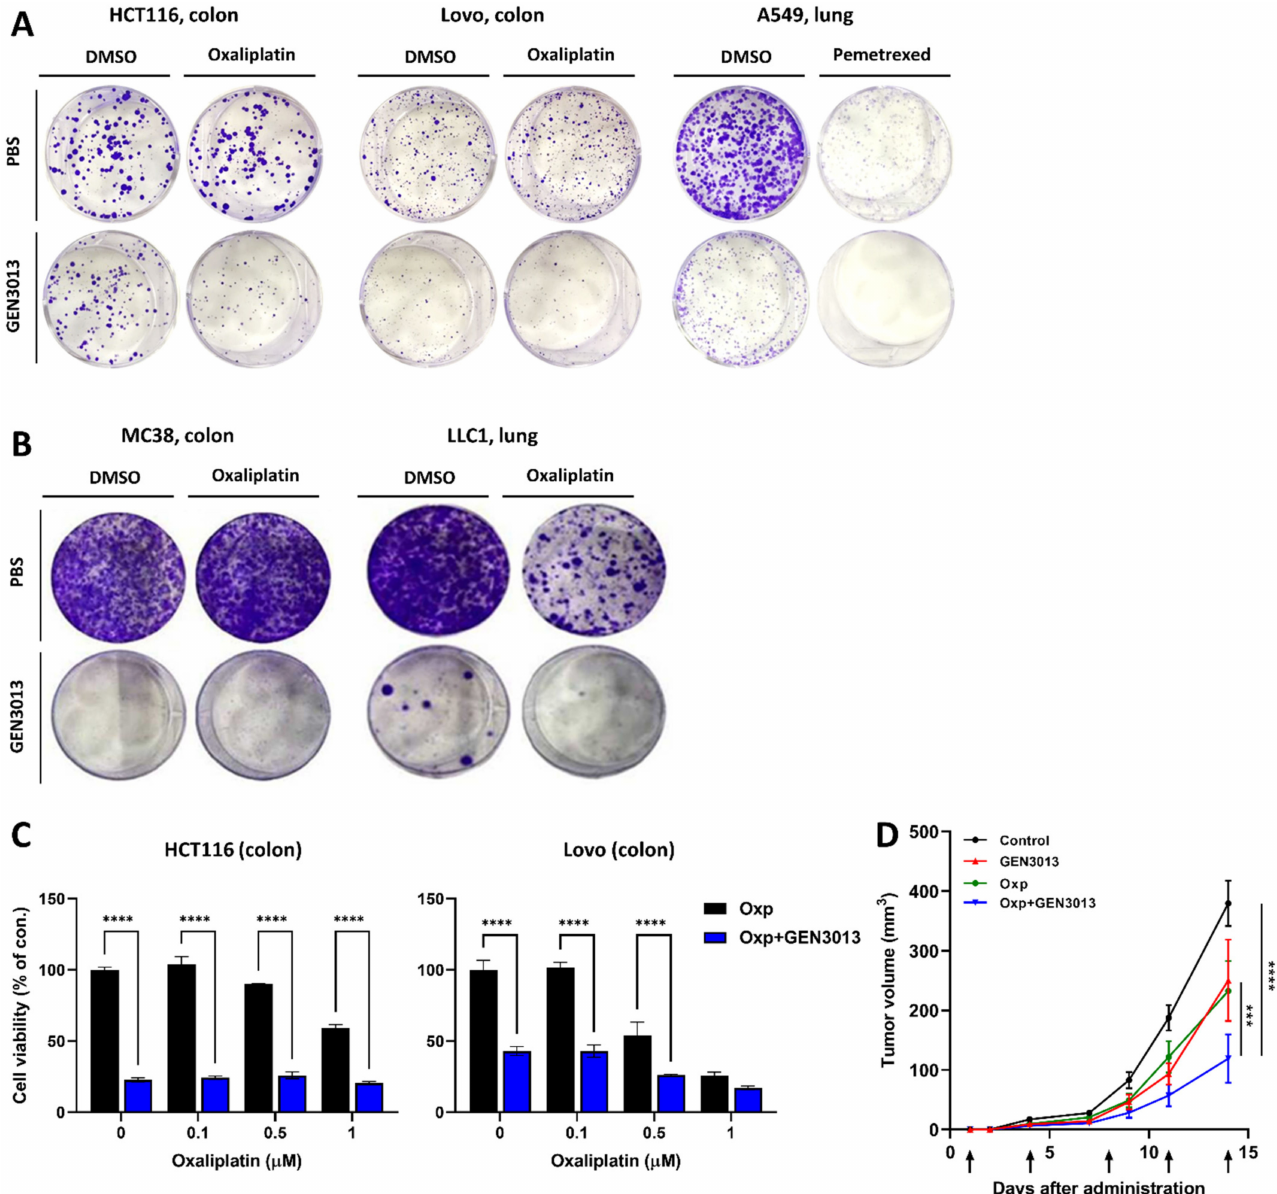
Figure 3. Lactococcus lactis GEN3013 enhances the therapeutic effects of chemotherapy. ( A , B ) Cancer cell growth inhibition was observed using crystal violet staining. HCT116 and LoVo human colon cancer cells were treated with 0.1 µ M oxaliplatin and A549 human lung cancer cells were treated with 0.05 µ M pemetrexed. MC38 and LLC1 mouse cancer cell lines were cultured with 2 µ M oxaliplatin. ( C ) The cell viability was measured after treating HCT116 and LoVo cancer cells with both oxaliplatin and L. lactis GEN3013. Oxaliplatin was administered dose-dependently (0, 0.1, 0.5 and 1 µ M), while the L. lactis GEN3013 dose was fixed at 0.5%. All concentrations of oxaliplatin showed increased efficacy in combination with L. lactis GEN3013 in both HCT116 and LoVo cells (oxaliplatin versus oxaliplatin + L. lactis GEN3013, p ≤ 0.0001 at all concentrations, except for 1 µ M oxaliplatin in LoVo cells). ( D ) C57BL/6 mice were inoculated with MC38 mouse cancer cells (N = 6–8 per group) 14 days after the initial oral administration of L. lactis GEN3013. While L. lactis GEN3013 was orally administered daily, oxaliplatin was intraperitoneally injected at 1, 4, 8, 11 and 14 days after